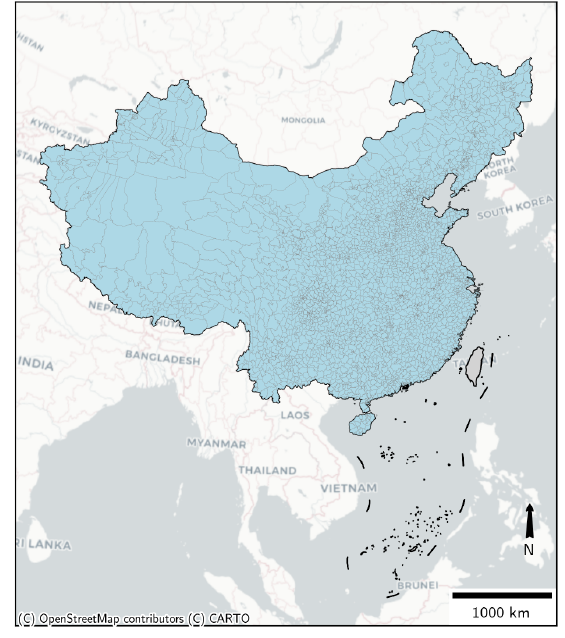
Figure 1. Study area of the mainland